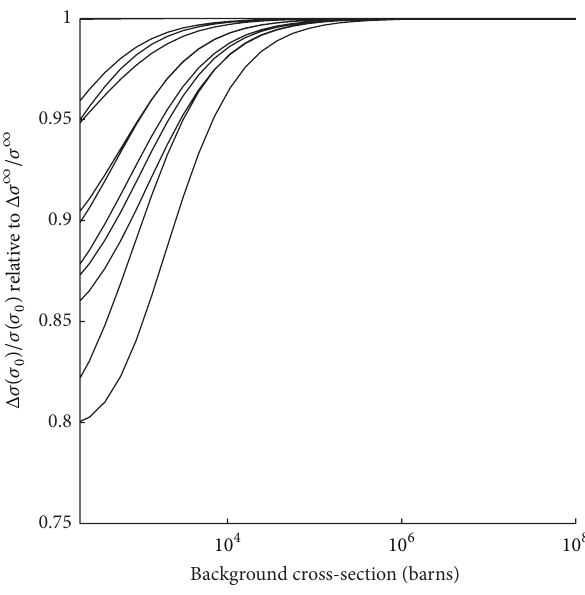
Figure 3: Resonance group Δ𝜎/𝜎 versus dilution relative to infinite dilution of 𝜎 U 235 𝛾 using